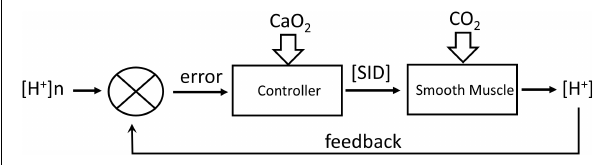
FIGURE 2 | Regulation of [H + ] by feedback control of [SID] by transmembrane transport of strongly dissociated ions. CO 2 acts as a disturbance to the system. CaO 2 acts to alter the controller